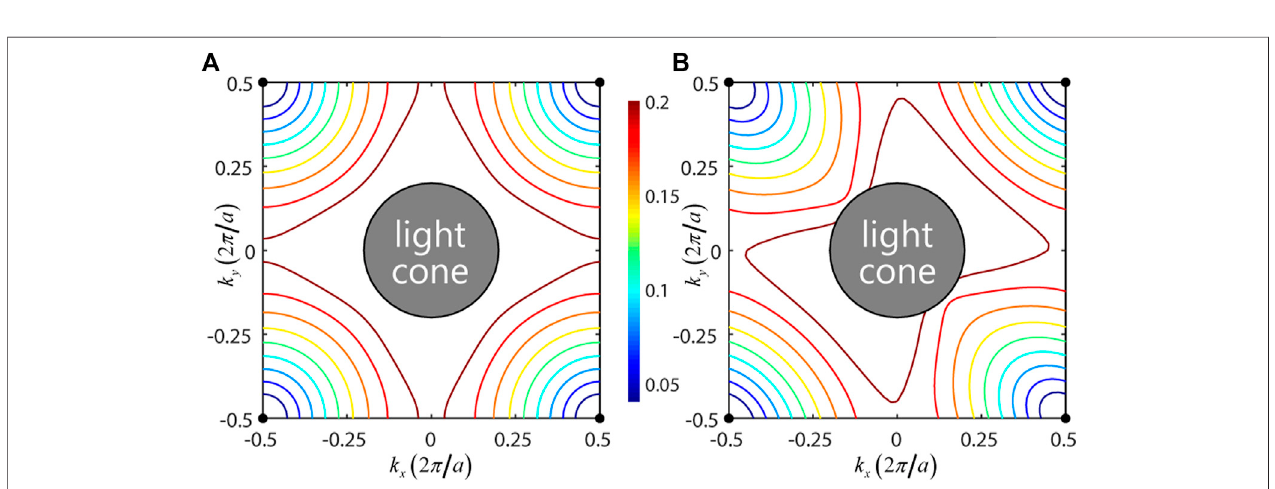
FIGURE 6 | MMs with (A) cruciform-shaped or (B) bowtie-shaped IFCs (simulation). Structural parameters: in (A) , height d = 0.42 a , width w p = 0.4 a , and (cid:2) w ^ (cid:2) 0 . 2 a ; in (B) , height d = 0.36 a , width w w ^ u u 2 1